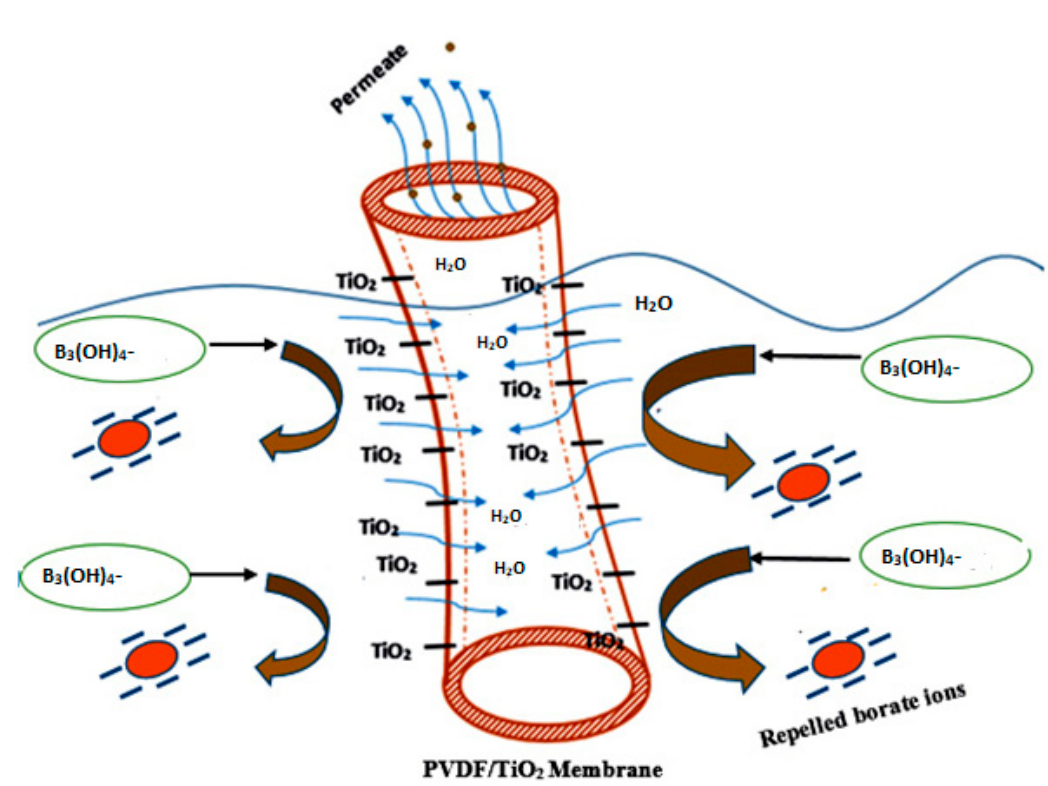
Figure 7. Boron rejection mechanism of the modified PVDF/PVP/TiO 2 membrane.